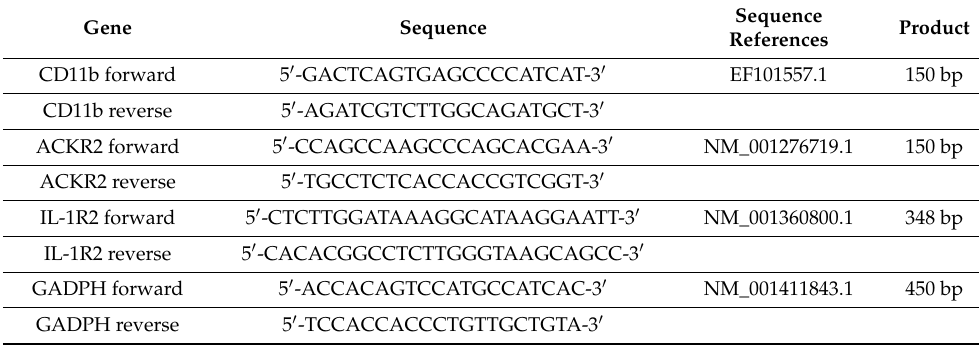
Table 1. List of primers for RT-PCR in N13 microglial cells.